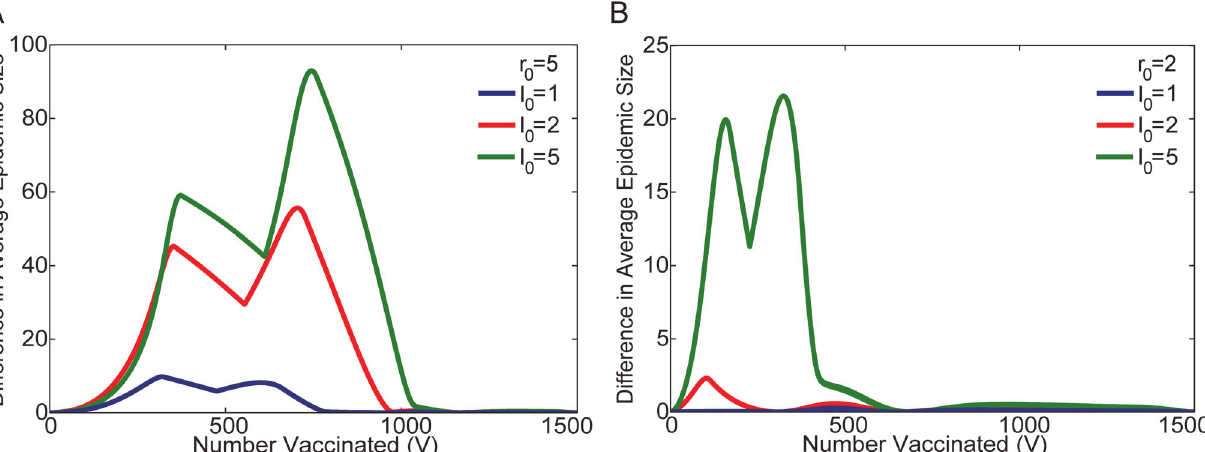
Fig 8. Comparison of Proportional and Stochastic Optimal Protocols. The difference in average epidemic size h E i obtained in the stochastic model, for a distribution that is directly proportional to population size ( N 1 = 500 and N 2 = 1000), compared to the optimal stochastic protocol. Results are shown for r 0 = 5 (Figure A), and r 0 = 2 (Figure B), and different values of of I 0 ( I 0 = 1, 2, and 5). The differences are most significant for large values of r 0 and I 0 , where the behavior of the stochastic model is most similar to the deterministic case. At smaller values of r 0 and I 0 the distinction is much less pronounced. The difference approaches zero for large amounts of vaccine, after effective herd immunity is reached in both populations, and the optimal protocol approaches proportional distribution. Note the difference in scale on the vertical axes for Fig. 8A and 8B.